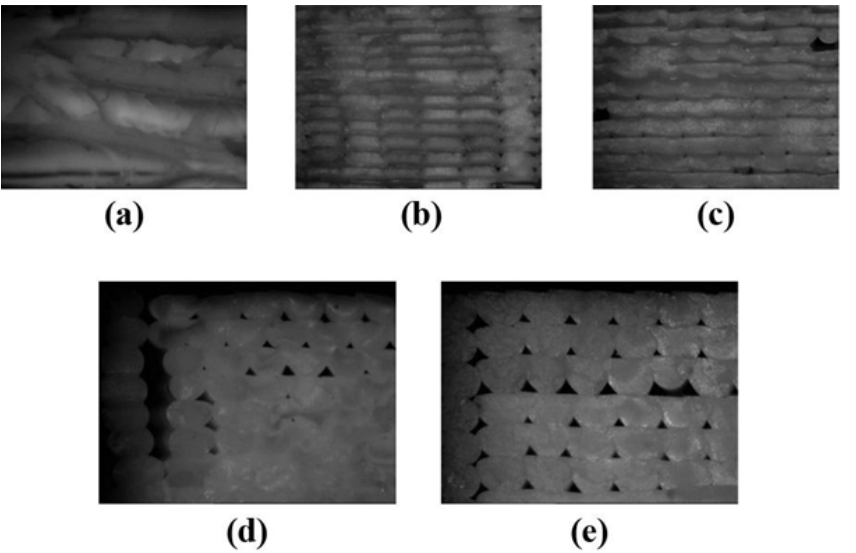
Figure 12. Microscopic images of the fractured surface with different printing layer thicknesses: ( a ) 100 µm, ( b ) 150 µm, ( c ) 200 µm, ( d ) 250 µm, and ( e ) 300 µm. Reprinted with permission from Ref. [92]. 2018, Elsevier.